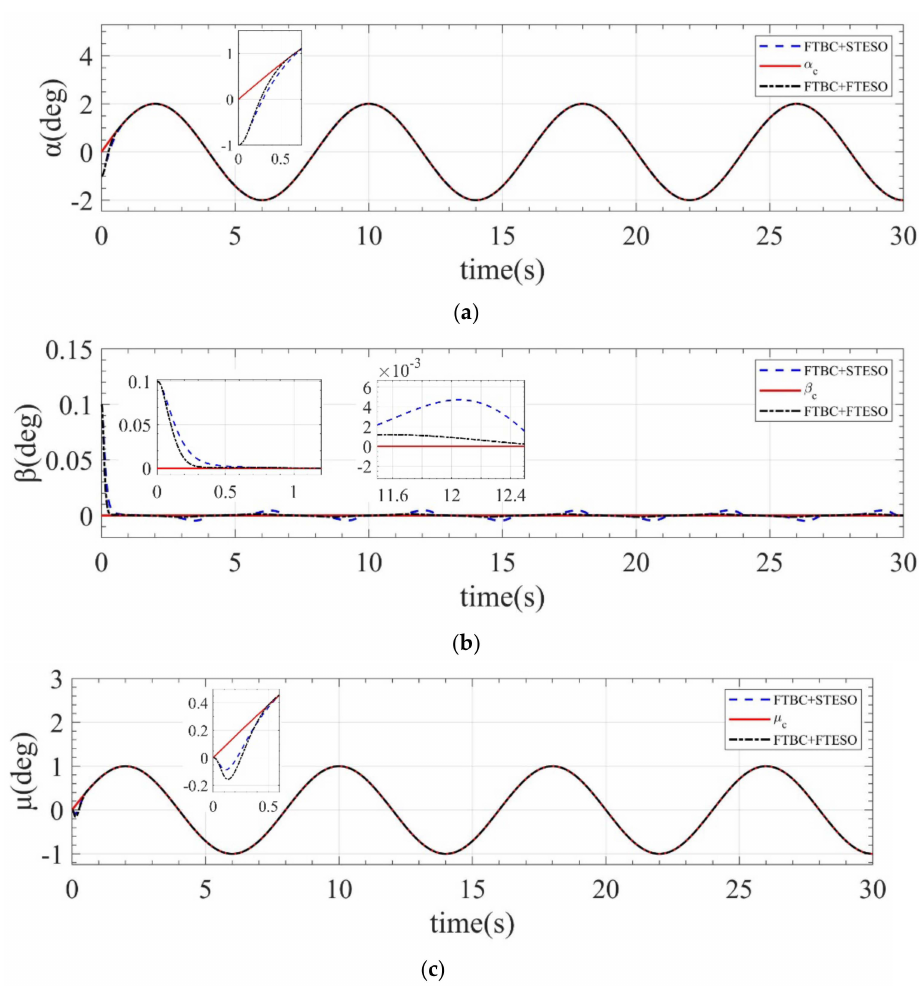
Figure 3. ( a ) Tracking curve of α , ( b ) tracking curve of β , and ( c ) tracking curve of µ